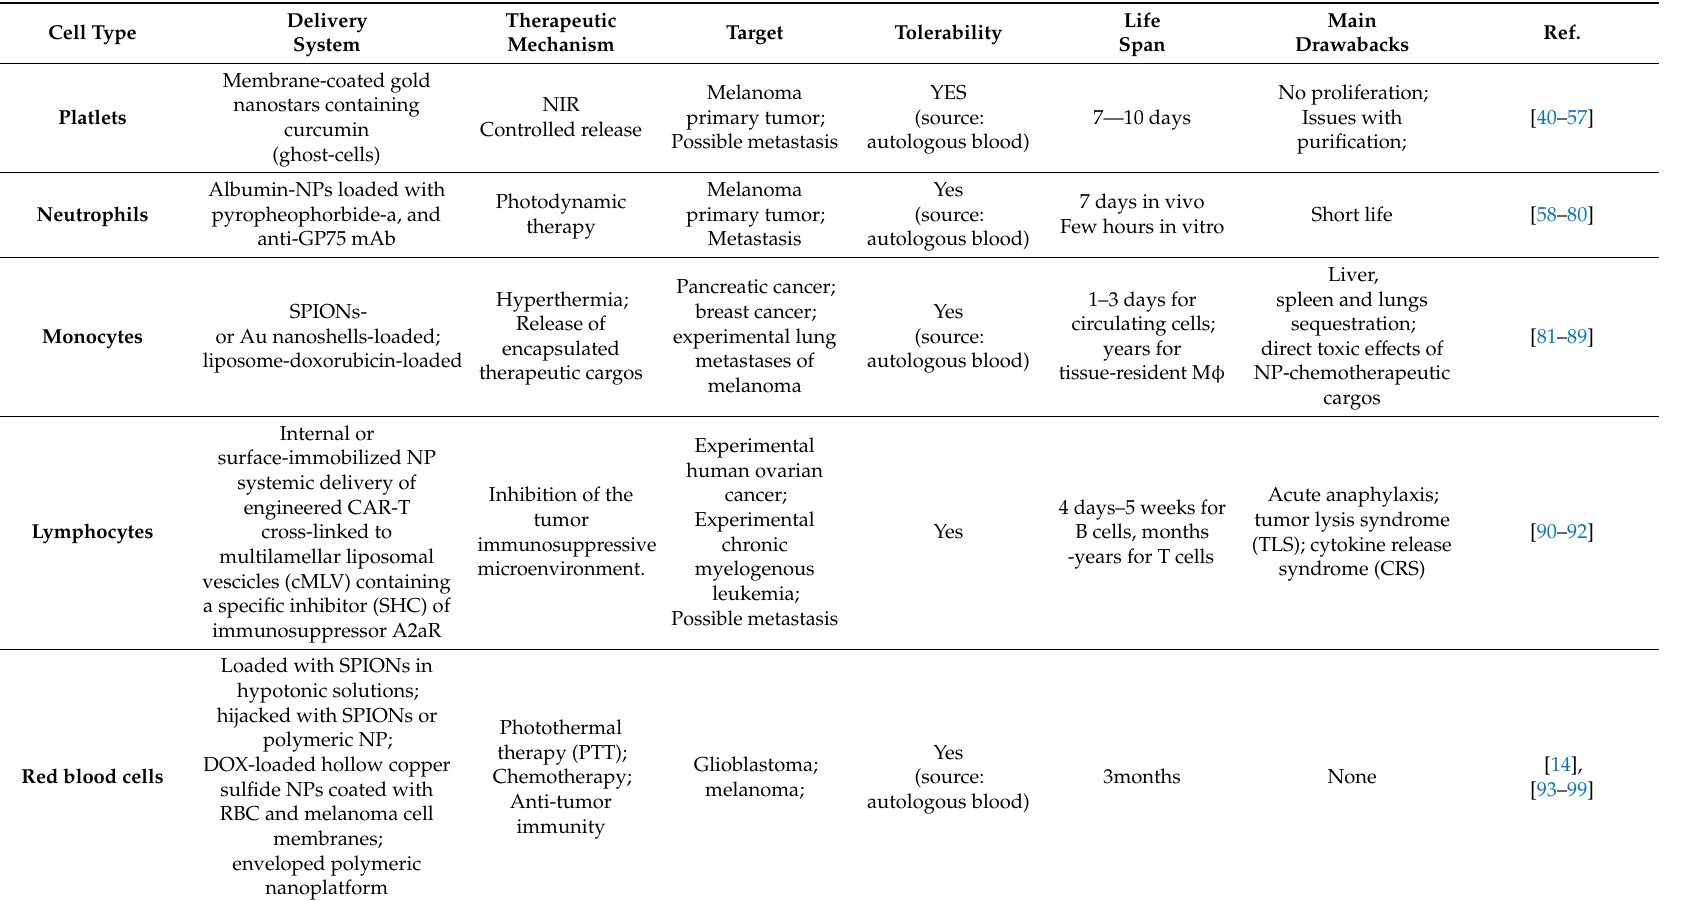
Table 1. Main features of cell-based nanoparticle delivery systems in cancer